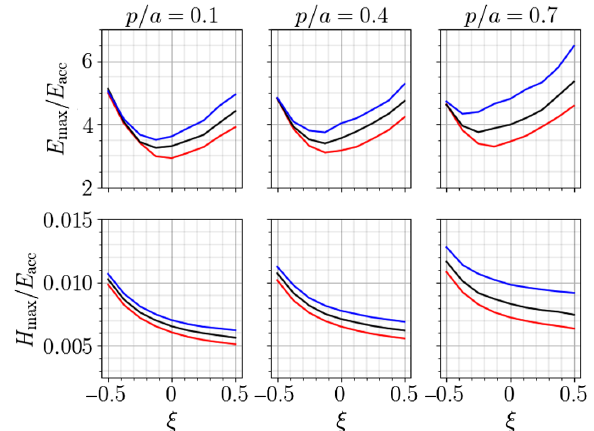
FIG. 10. Normalized peak surface E (V m − 1 ) and H (A m − 1 ) fields of the maximum radii corrugation geometry with a= λ ¼ 0 . 53 (red), a= λ ¼ 0 . 60 (black), and a= λ ¼ 0 . 67